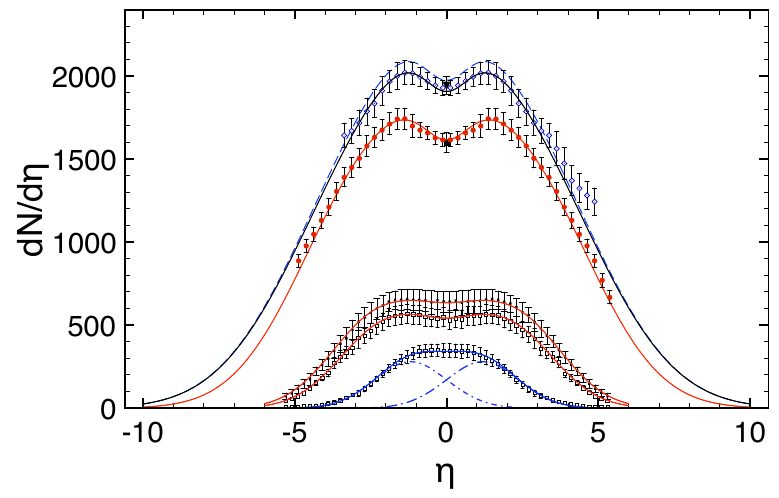
Figure 8. The relativistic diffusion model (RDM) pseudorapidity distribution functions for charged hadrons in central Au-Au (RHIC) and Pb-Pb (LHC) collisions at c.m. energies of 19.6 GeV, 130 GeV, 200 GeV, 2.76 TeV, and 5.02 TeV shown here are optimized in χ 2 -fits with respect to the PHOBOS [18,54] (bottom) and ALICE [46,56] (top) data, with parameters from References[15,16]. The upper dashed distribution function at 5.02 TeV is a prediction from Reference[16] within the relativistic diffusion model. The 5.02 TeV midrapidity data point is from Reference[57], the 5.02 TeV data from Reference[46]. The 19.6 GeV distribution has only two sources (dot-dashed), the other ones have